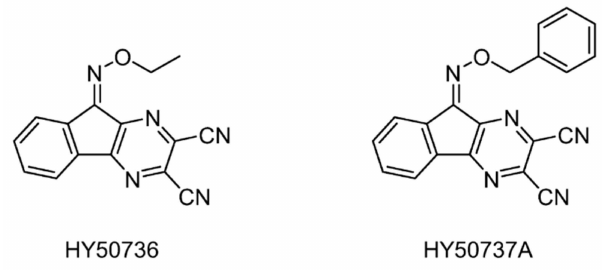
Figure 16. Structures of reported USP7/8 inhibitors.